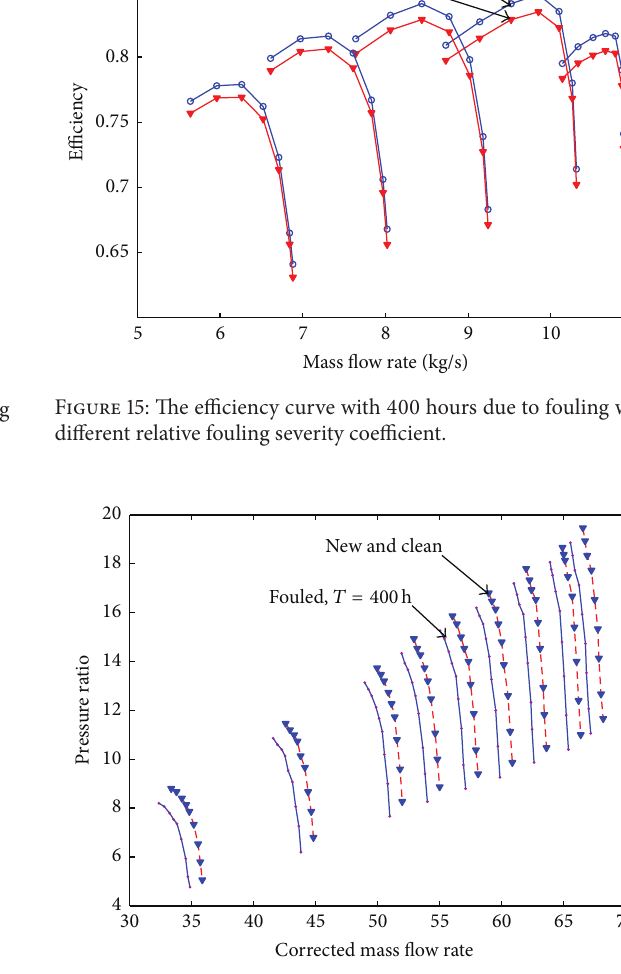
Figure 16: The pressure ratio curve of LM2500-30 with 400 hours due to fouling with different relative fouling severity